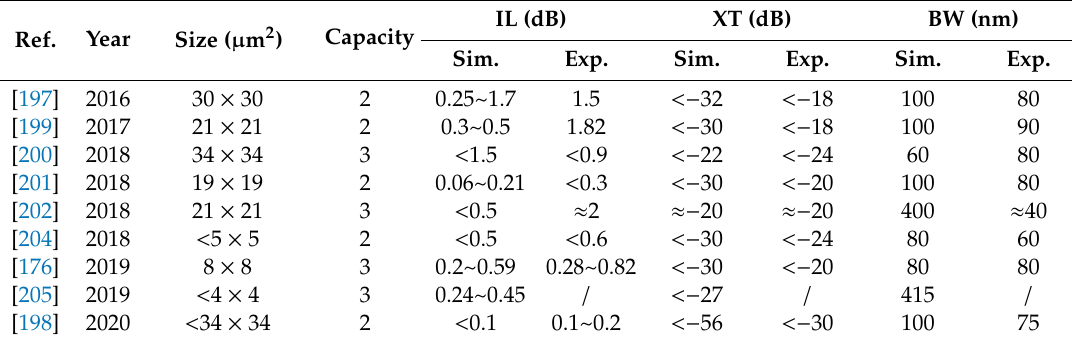
Table 6. Summary of the reported silicon multi-mode